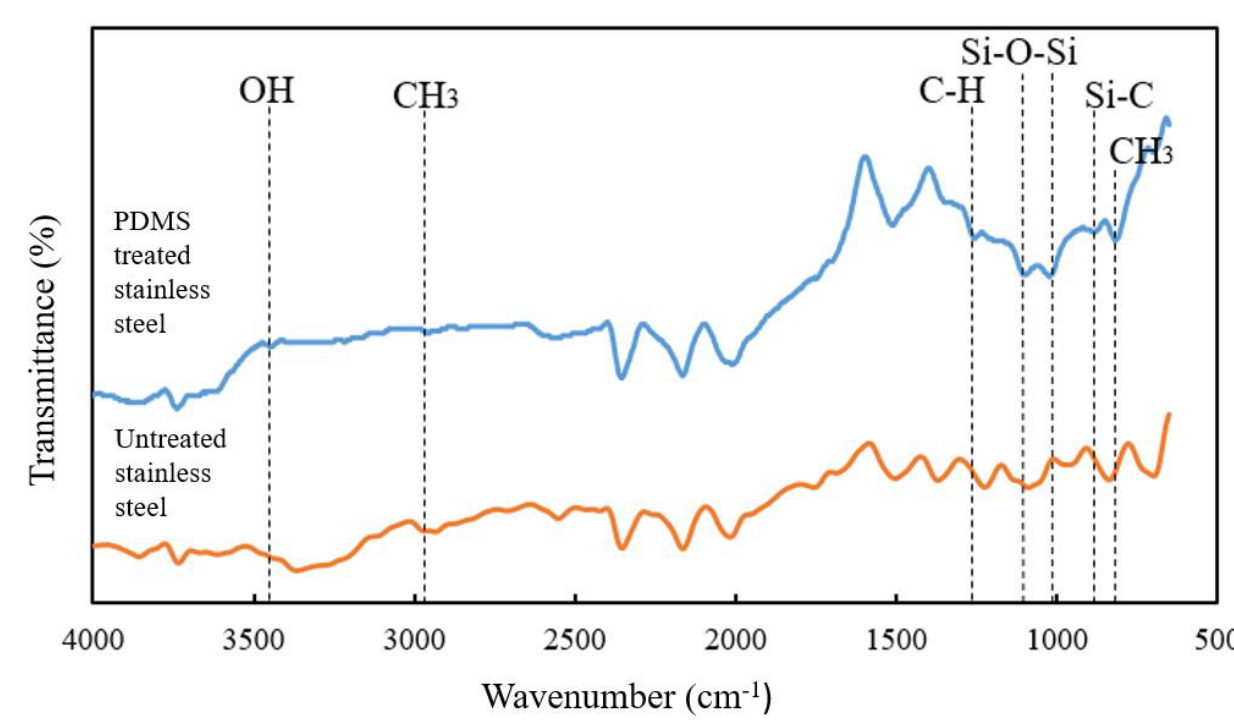
Figure 8. FTIR spectra of the untreated and PDMS-treated stainless steel surfaces.